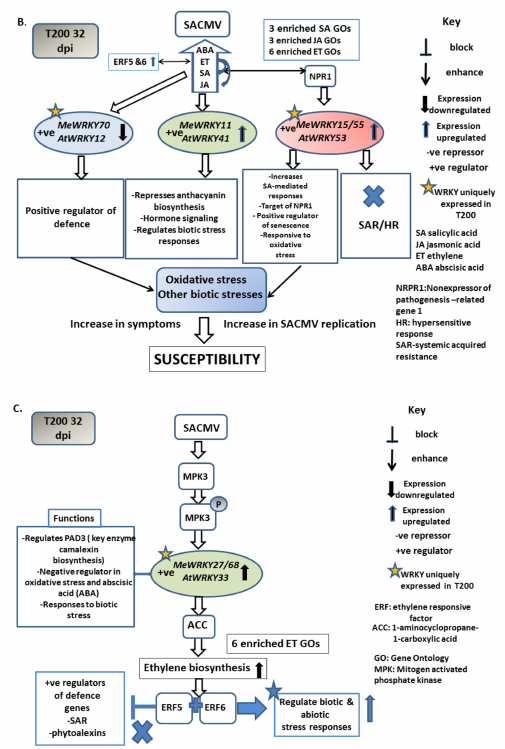
Figure 9. Proposed models of WRKY functions, hormones and downstream signaling of responses to SACMV in T200 and TME3 at 32 dpi. ( A ) TME3 exhibits milder symptoms compared to T200 in response to SACMV. This is associated with a number of upregulated hormone genes, JA, ABA, SA and ET, as a general response to infection. While a number of SA genes are upregulated, they are not significantly represented in the enriched GO (biological process) categories. In contrast to mock-inoculated plants, upregulation of MeWRKY3 , 11 and 18 expression is observed. These transcription factors positively regulate hormone biosynthesis and signaling and biotic and oxidative stress functions. Differential expression of MeWRKY11 is specifically associated with an ABA response, a hallmark of abiotic and biotic stress. These responses to WRKY expression contribute at a later stage to a lower viral load and symptom recovery observed at 67 dpi and tolerance to SACMV. ( B ) T200 exhibits severe symptoms in response to SACMV. This is associated with a number of upregulated hormones JA, ABA, SA and ET genes as a general response to infection. However, while a number of ABA genes are upregulated, they are not significantly represented in the enriched GO (biological process) categories. In contrast to mock-inoculated plants, upregulated expression of MeWRKY3 , 5/55 and 70 is observed. AtWRKY12 is a known positive regulator of plant defense,